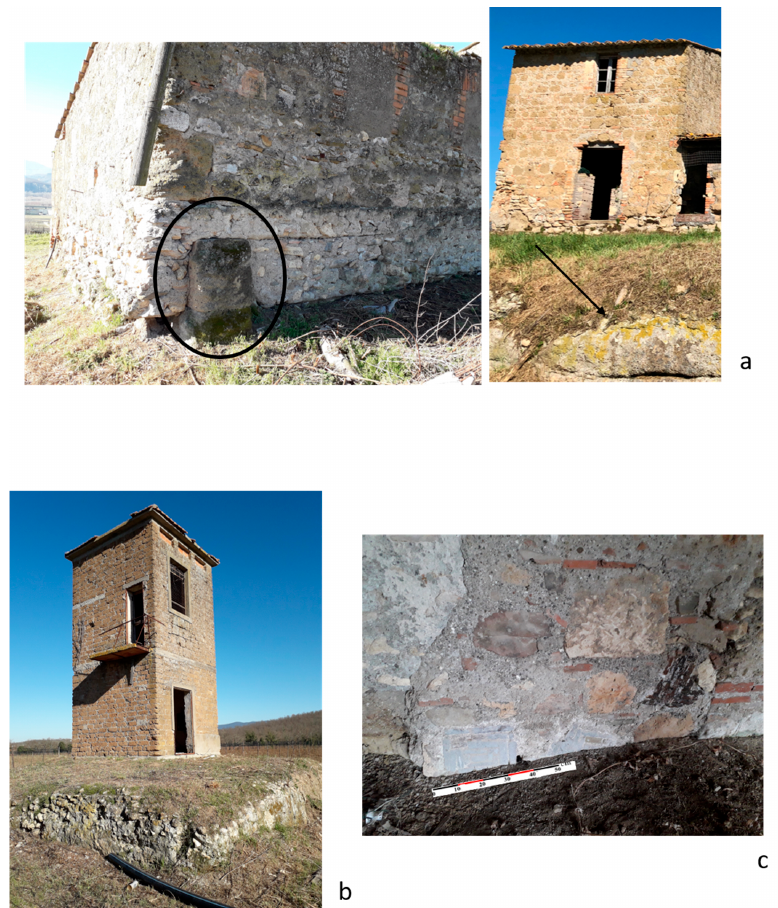
Figure 3. The site of Malvicino, including modern constructions. ( a The pigsty with probable ancient masonry blocks still in situ (circled in black) and the remains of the retaining wall or partially preserved cistern (indicated by the black arrow). ( b ) The electrical tower standing on top of a platform that is partially constructed of opus caementicium . ( c ) Ancient Roman fragments reused to decorate the walls of the modern